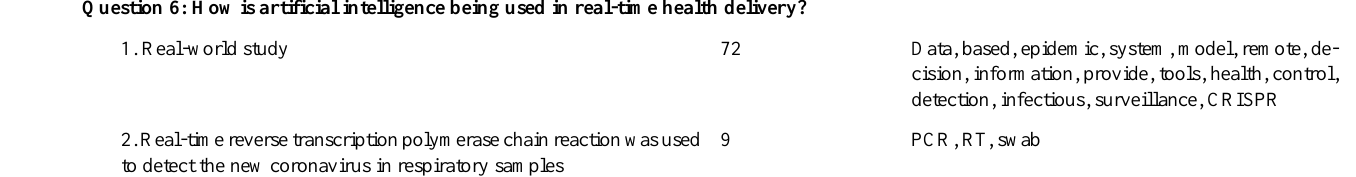
to detect the new coronavirus in respiratory samples a Number of answers classified to each opinion (ie, in each k-means cluster). b N/A: not